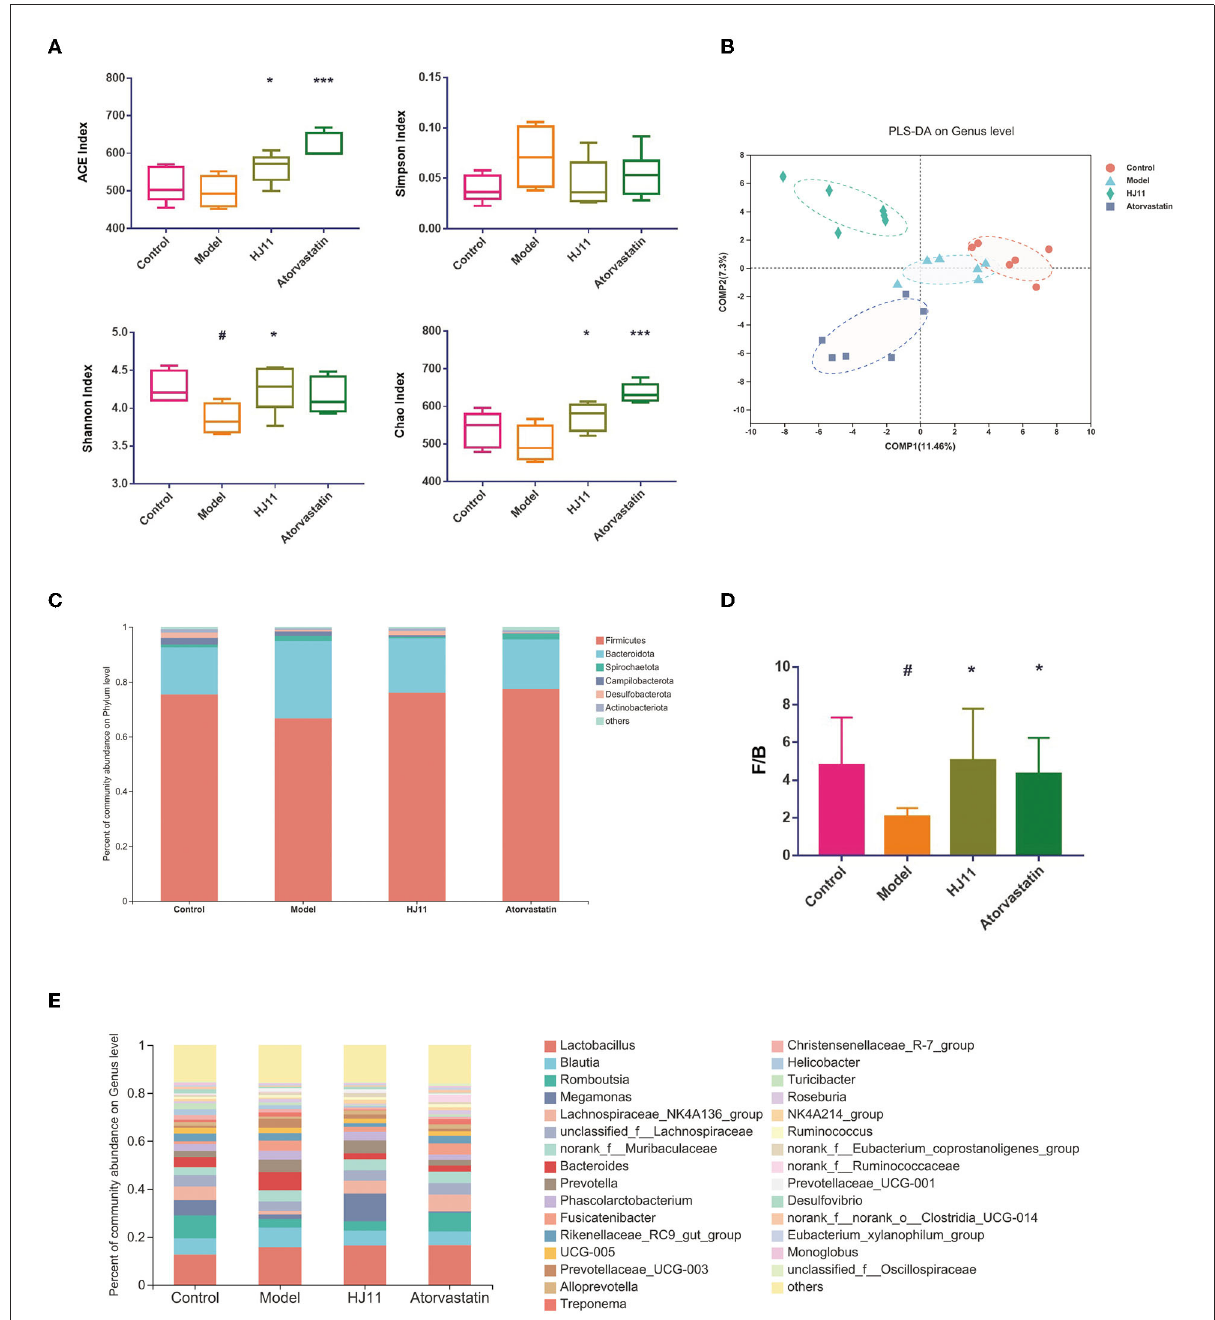
FIGURE4 Microbial community structures in different groups. (A) α -Diversity in different groups. (B) PLS-DA of different groups. Points with the same color and shape represent samples from the same group. Distances between points reflect differences between samples. (C) Comparison of community composition at the phylum level. Each column represents a group. (D) F/B ratio. (E) Comparison of community composition at the genus level. Each column represents a group. # P < 0.05, # P < 0.01 compared with the control group; * P < 0.05, *** P < 0.001 compared with the model